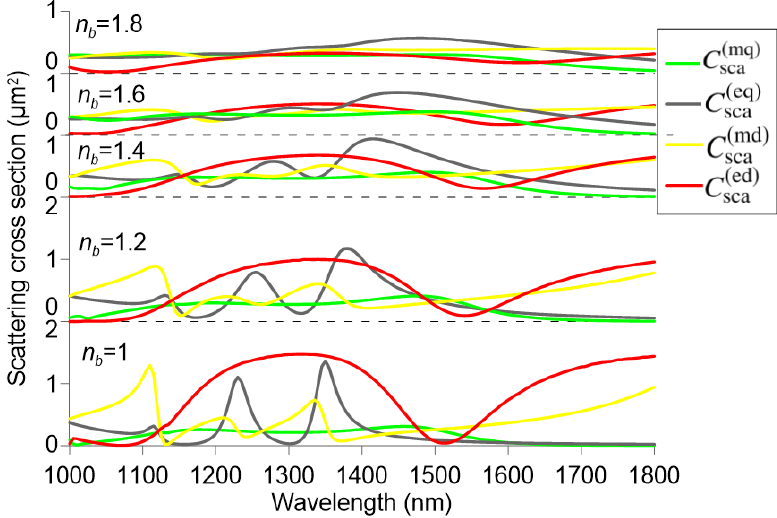
Figure 3. Multipole decomposition for a silicon cuboid nanoparticle ( a = 602 nm, h / a = 0.6, b / a = 0.2) for different values of the refractive index n b of the surrounding